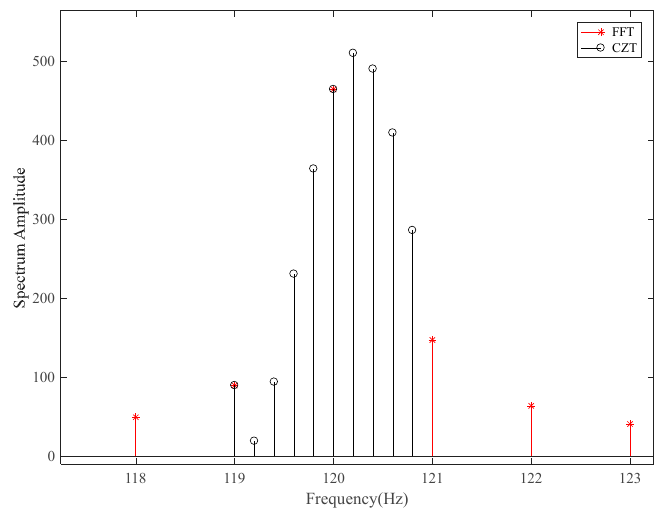
Figure 1. The spectrum comparison of CZT and FFT.